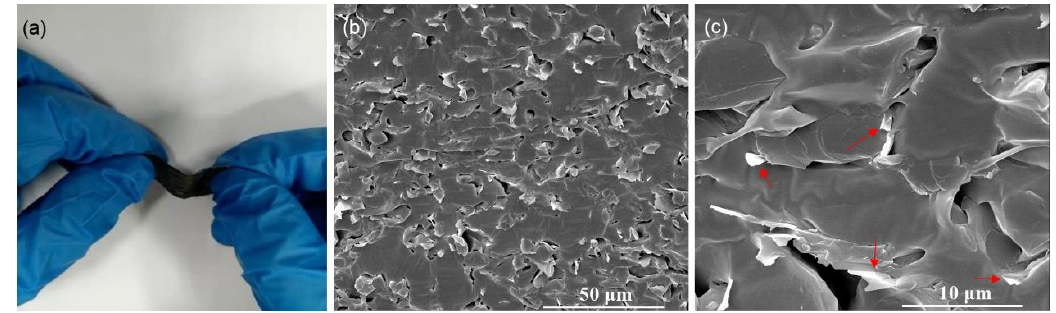
Figure 5. ( a ) A bending PDMS/GN composite; ( b ) and ( c ) SEM images of the PDMS/GN composite, the red arrows in (c) indicates the graphene.